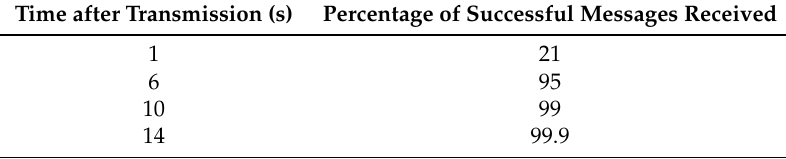
Table 6. Delays between transmission and logging of LoRaWAN message. This data only includes messages that were successfully delivered.